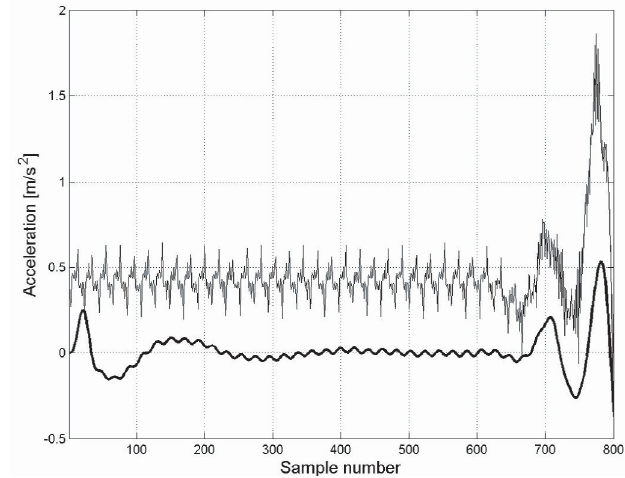
Fig. 4. Initial part of the raw signal (fine line) and the corre- sponding filtered one (thick